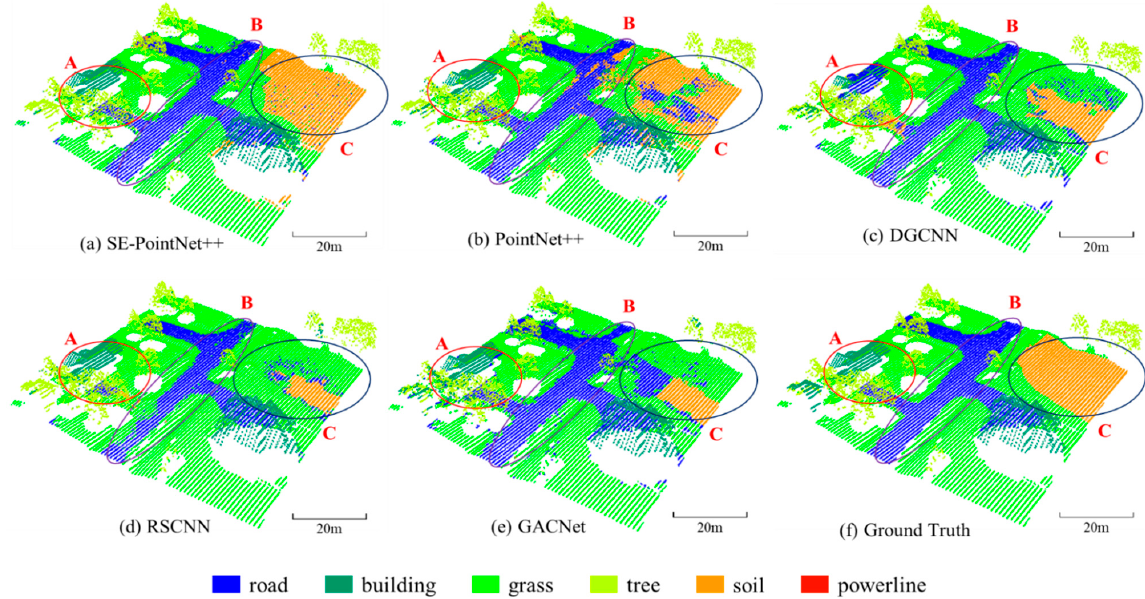
Figure 9. Illustration of a close-up view of the comparative point cloud classification results. ( a ) SE-PointNet++, ( b ) PointNet++, ( c ) DGCNN, ( d ) RSCNN, ( e ) GACNet and ( f ) Ground truth.